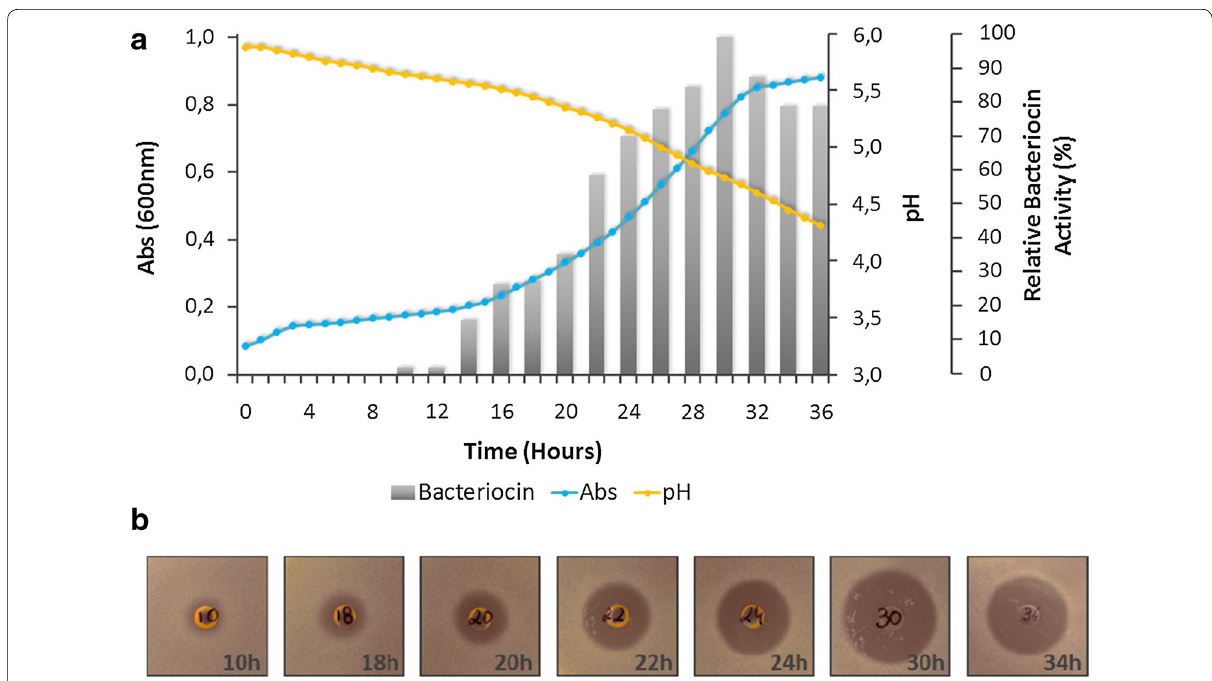
Fig. 2 a Batch fermentation of Lactobacillus acidophilus KS400 strain in MRSB with non‑controlled pH (initial value of 6.5) at 37 °C. Left axis: absorvance (Abs) at 600 nm; Primary right axis: pH values; Secondary right axis: Relative bacteriocin activity (%); Bottom axis: Time (hours). Symbols: Optical density at 600 nm; Changes in pH values; (‑grey bars‑) Bacteriocin activity production. b Antimicrobial activity of Lactobacillus acidophilus KS400 strain during fermentation; Activity was tested against Lactobacillus delbrueckii ATCC9649 and plates were incubated at 37 °C;